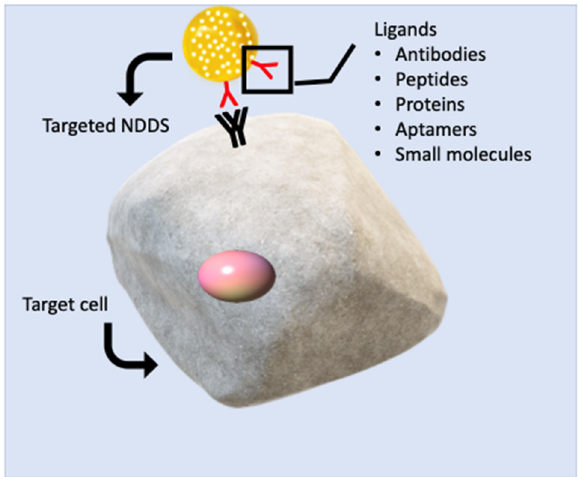
Figure 14. Receptor-mediated active targeting of ligand-modified NDDS. NDDS bind to the relevant specific receptor on the cell surface via the targeting ligands on their structure. NDDS, which undergo receptor-mediated endocytosis after binding, internalize into the cell and release the encapsulated active molecule in the target cell.